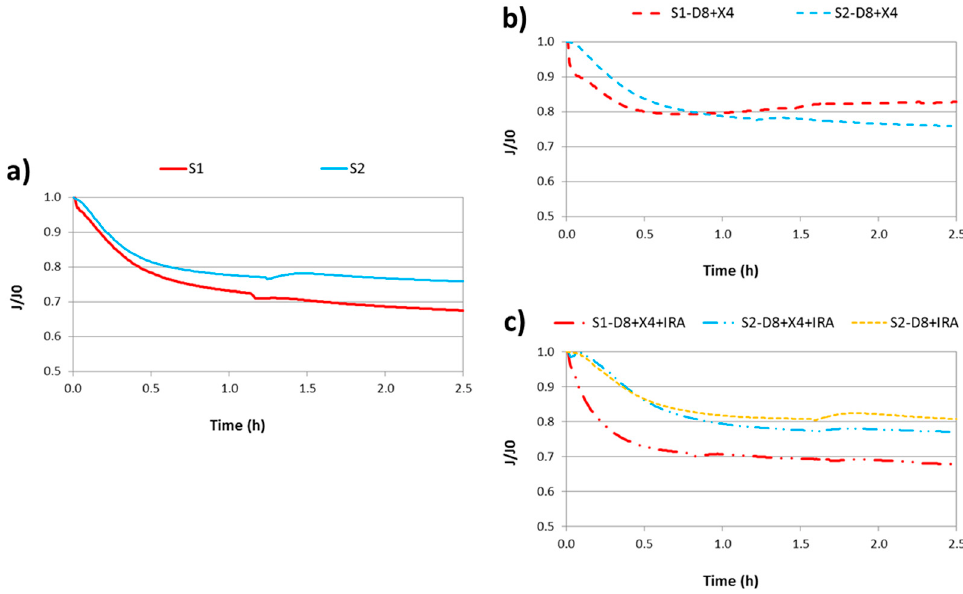
Figure 2. Ultrafiltration tests: ( a ) raw secondary effluents; ( b ) effluents after XAD ‐ 8 and DAX ‐ 4 treatment (hydrophilic substances); ( c ) effluents after XAD ‐ 8, DAX ‐ 4 and IRA ‐ 598 treatment (neutral hydrophilic substances).